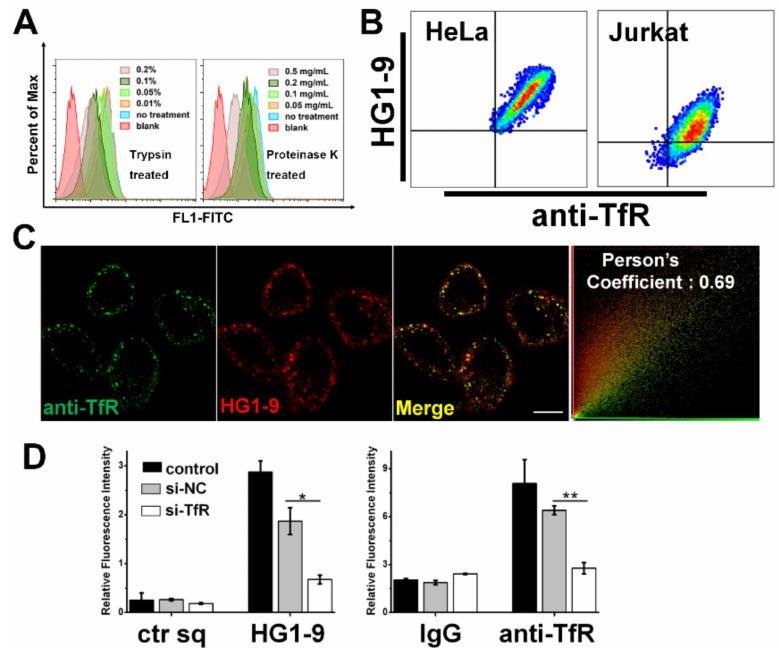
Figure 4. Identification of transferrin receptor as molecular target of aptamer HG1-9. ( A ) Flow cytometry analysis of HG1-9 binding to Jurkat cells pretreated by different concentrations of trypsin or proteinase K. ( B ) Flow cytometry analysis of HeLa and Jurkat cells dual-stained by aptamer HG1-9 (labeled by Cy5) and antibody anti-TfR (labeled by PE). The cross-quadrant gate in each bivariate histogram was respectively set according to negative control in different cell lines. ( C ) Confocal imag- ing of HeLa cells dual-stained by aptamer HG1-9 (labeled by FITC, 200 nM) and anti-TfR antibody (labeled by PE-second antibody, dilution of 1:20), the scale is 10 µ m. ( D ) Relative median fluorescence intensities of aptamer HG1-9 and anti-TfR antibody binding to HeLa cells after siRNA knockdown. Relative median fluorescence intensities were acquired according to formula of F = (F1 − F0)/F0. Blank bars represent cells without any treatment, grey bars represent cells treated by si-NC sequence, and white bars represent cells treated by si-TfR. The ctr sq and IgG were as the negative control, t -test, n = 3, * p < 0.05; ** p <